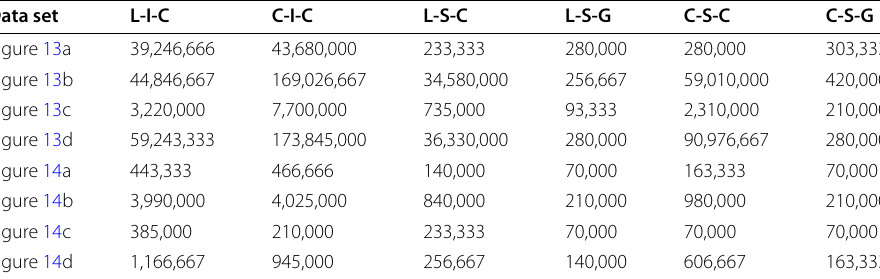
performance degradation of two independent methods on the skewed data in the previ- ous experiments. The time on the first phase for two independent methods in Fig. 13c and d is similar and just the proportion in the total execution time is different. This